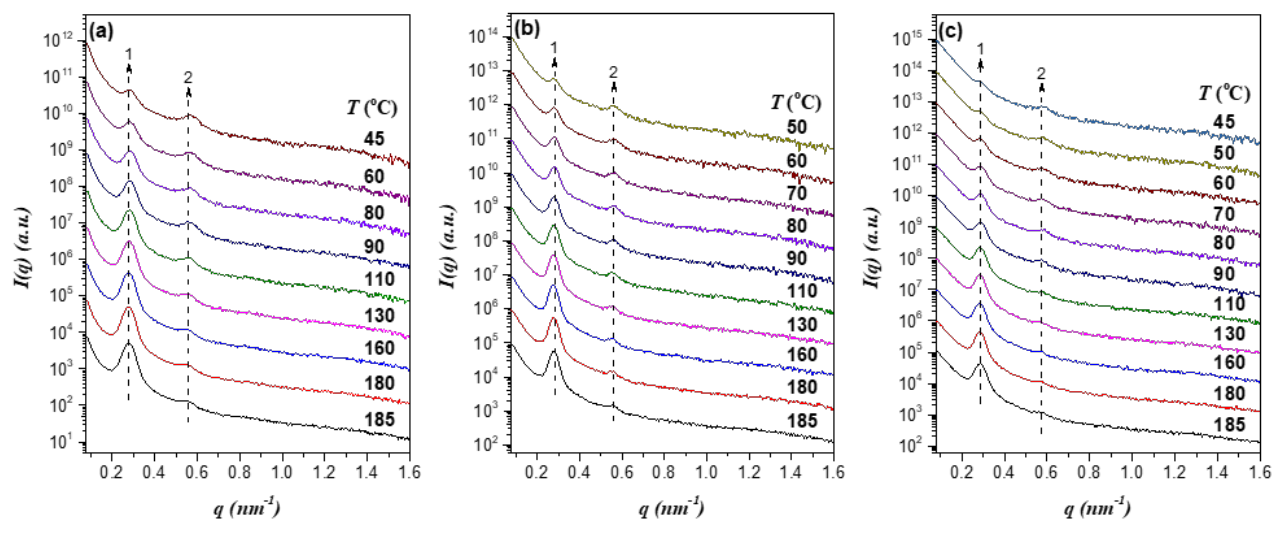
Figure 3. Temperature-dependent SAXS profiles of the EO4VP/h-P4VP1 blends with the overall volume fractions of P4VP of ( a ) f P4VP = 0.66, ( b ) f P4VP = 0.69, and ( c ) f P4VP = 0.71 collected in a cooling cycle. The scattering curves are shifted vertically for the clarity of presentation. As that found for neat EO4VP, the primary peak diminished and broadened progressively with decreasing tempera- ture.